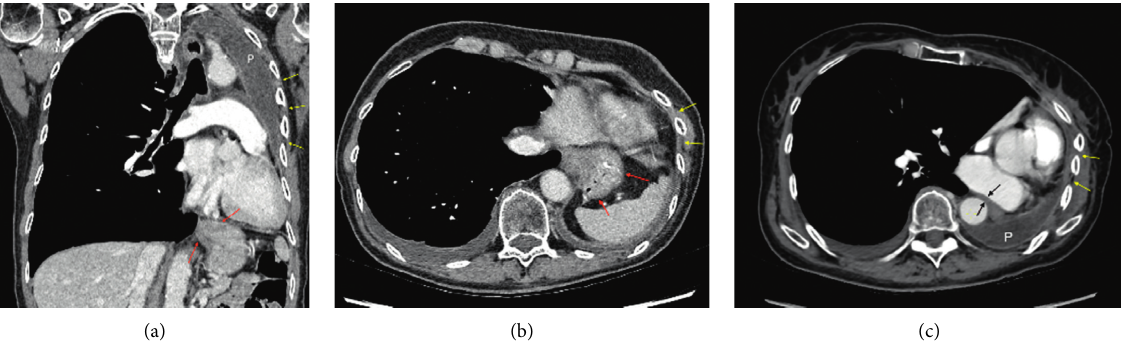
Figure 2: Coronal (a) and axial (b, c) reformats on contrast-enhanced chest CT more saliently depict the leftward cardiomediastinal shift and ipsilateral intercostal space narrowing (yellow arrows). Expected postsurgical fluid filling the pneumectomy space is present only along the superoposterior left hemithorax (labeled P). A small hiatal hernia is present (red arrows), which may be partly due to the tortuous course of the esophagus in the left hemithorax and consequent upward traction on the stomach. There may be some extrinsic compression on the esophagus (black arrows) between the left atrium and descending thoracic aorta, although an obstruction or poor distensibility was suggested on